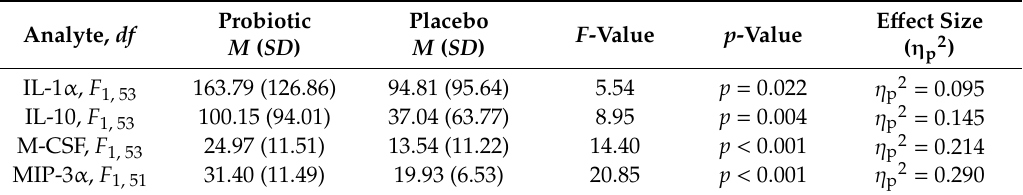
Table 4. Overview of treatment main e ff ects for plasma inflammatory analytes from factorial ANOVA analyses for IL-1 α , IL-10, M-CSF, and MIP-3 α , including means ( M ) and standard deviations ( SD ).